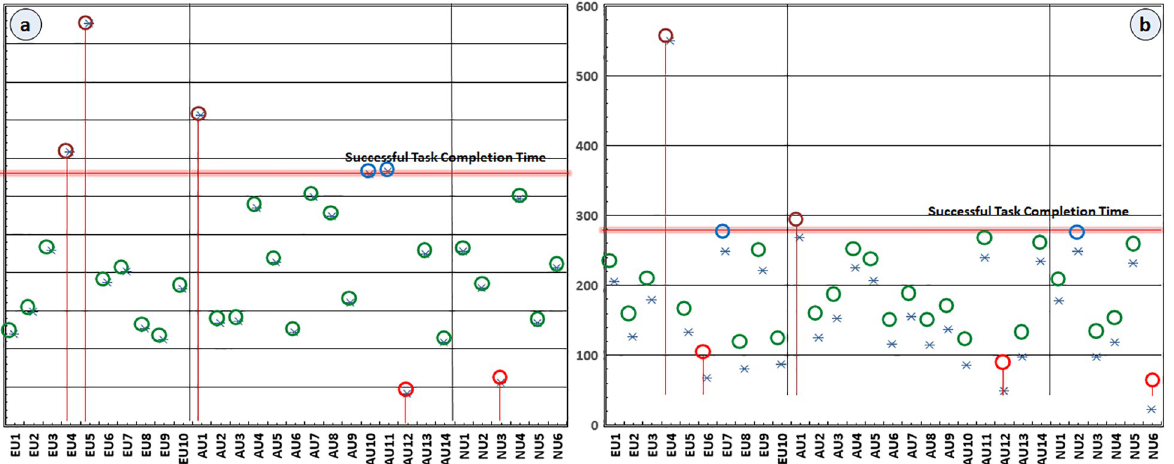
Fig 8. Respondents task completion time of exploration tasks ET 1 (a) and ET 1 (b).